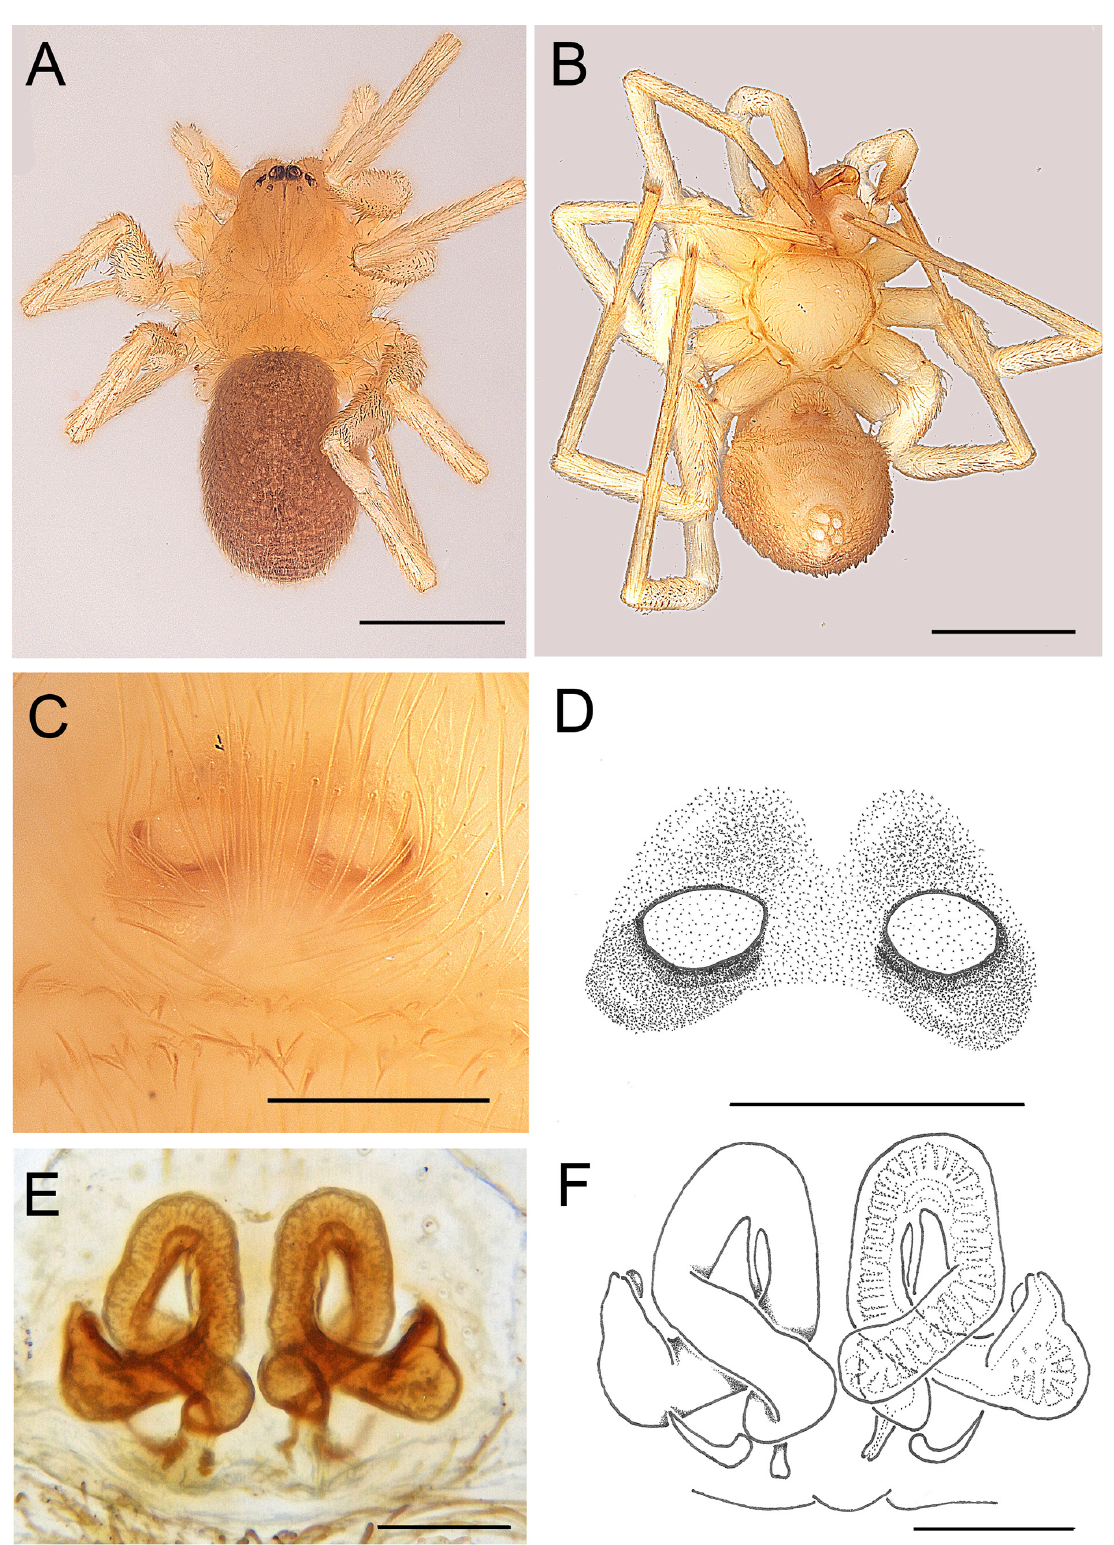
Fig. 12. Andromma cyamos sp. nov., ♀, holotype (BE_RMCA_ARA.Ara 155566). A . Habitus, dorsal view. B . Same, ventral view. C–D . Epigyne, ventral view. E–F . Same cleared, dorsal view. Scale bars: A–B = 1 mm; C–D = 0.2 mm; E–F =